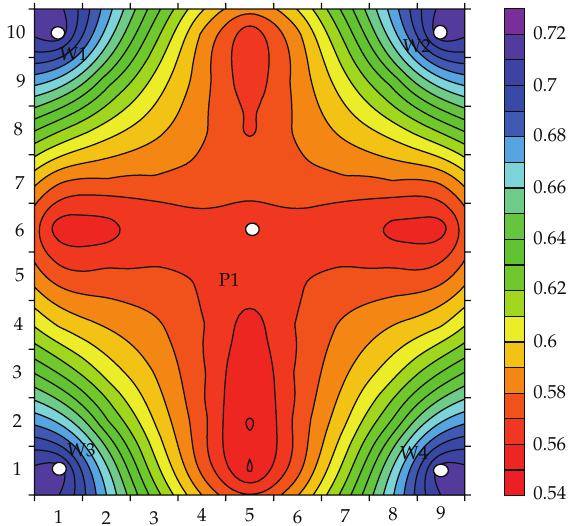
Figure 2: Initial water saturation contour